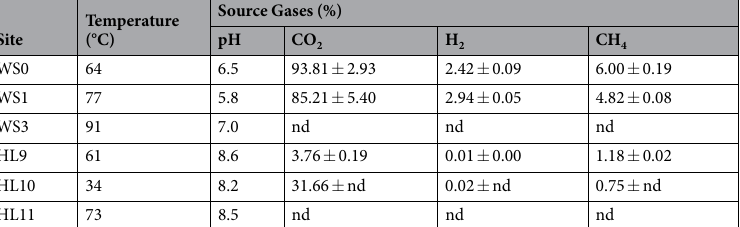
Table 1. Physicochemical attributes of Washburn (WS) and Heart Lake Geyser Basin (HL) hot springs. Temperatures and pH values are listed for each hot spring sampled at WS and HL. Geothermal source gas bubbles were captured and analyzed for the presence of CO 2 , H 2 , and CH 4 ( ± values are equal to the standard deviation of the mean percentage value based on quadruplicate resampling). Time and weather constraints prevented replicate sampling from being collected at HL10. Collection of source gases was not possible at WS3, which is not fully submerged in spring fluid, and HL11, which did not produce observable bubbles (nd = not